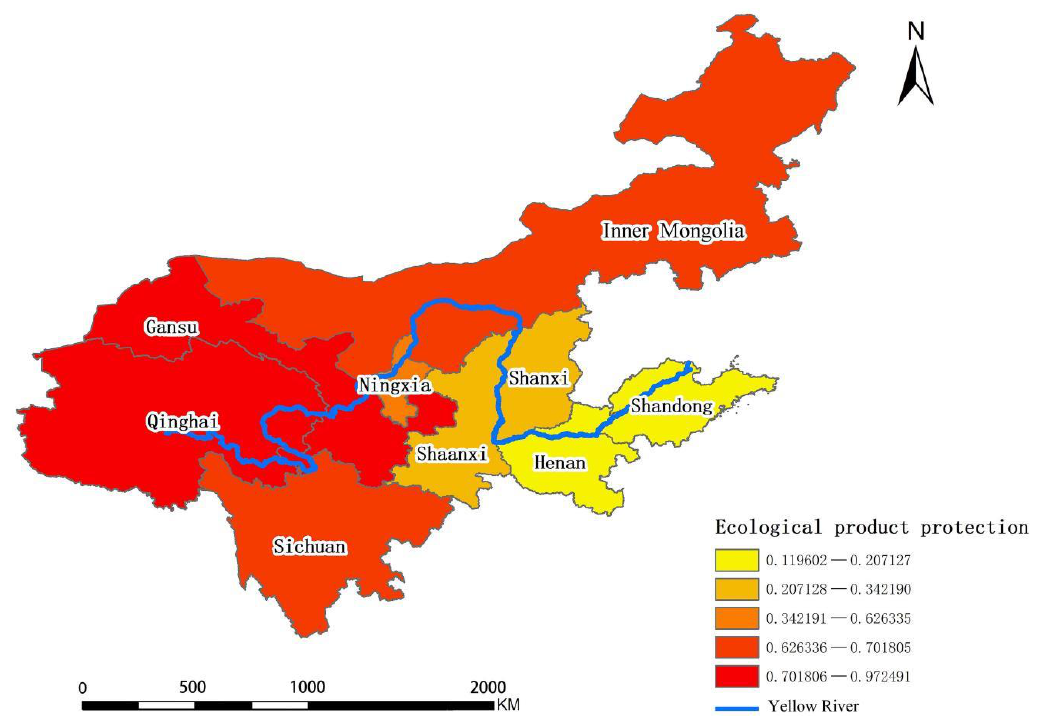
Figure 4. Ecological product protection level